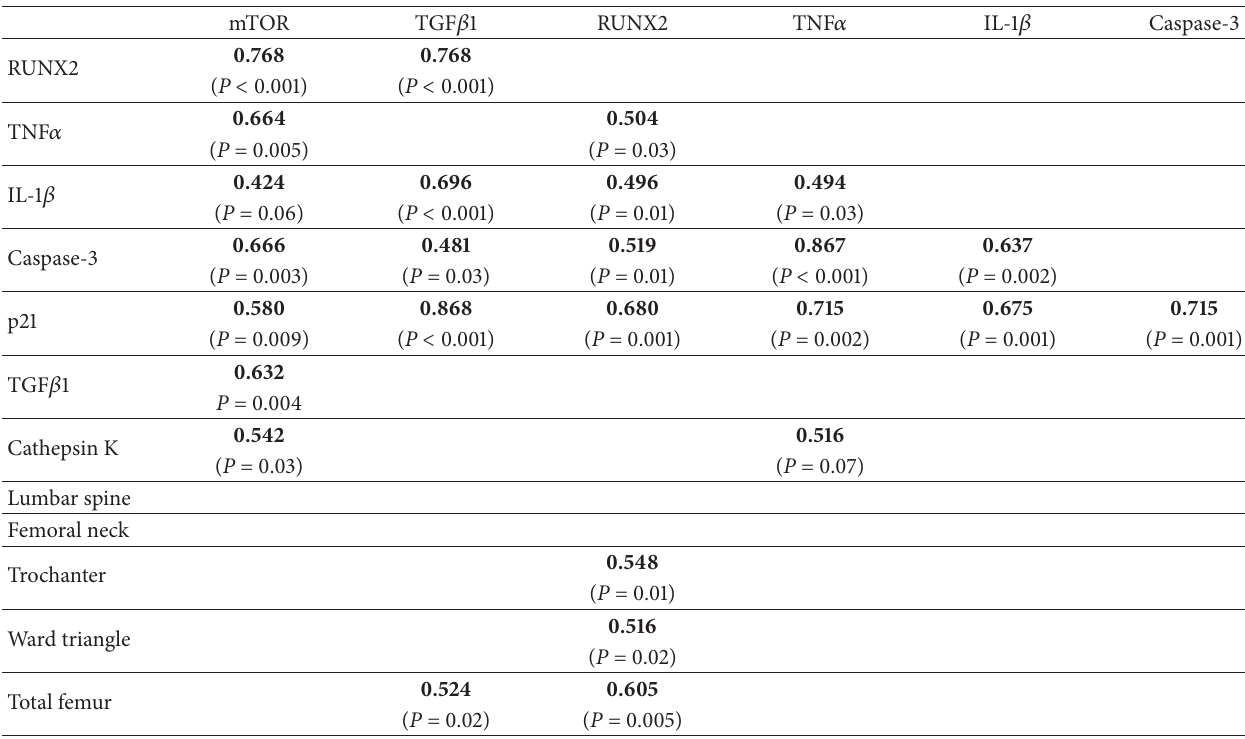
Table 2: Correlation coefficients and their significance ( 𝑃 ) are shown for the expression of cell growth and differentiation-related genes in relation to BMD in postmenopausal osteoporotic